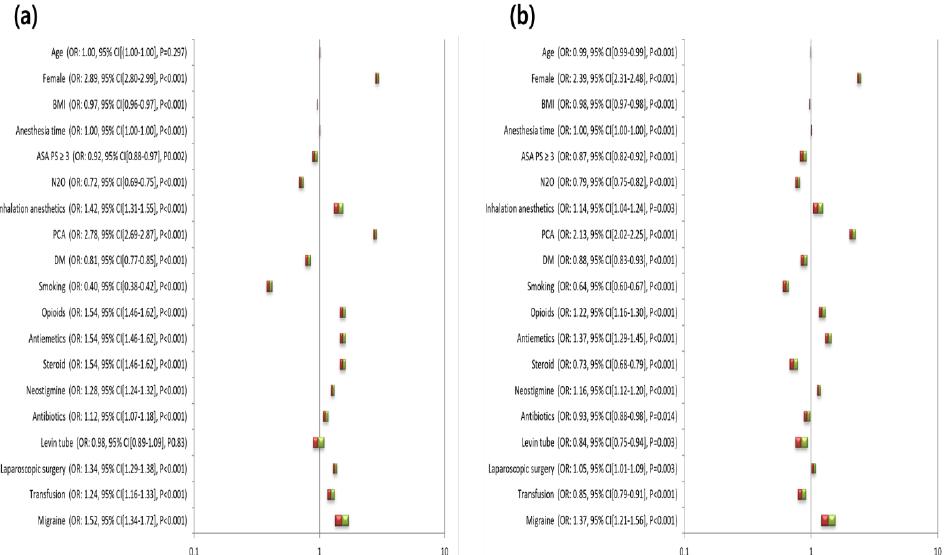
Figure 1. Unadjusted ( a ) and fully adjusted ( b ) odds ratios for postoperative nausea and vomiting of Figure1. Unadjusted( a )andfullyadjusted( b )oddsratiosforpostoperativenauseaandvomitingofeach